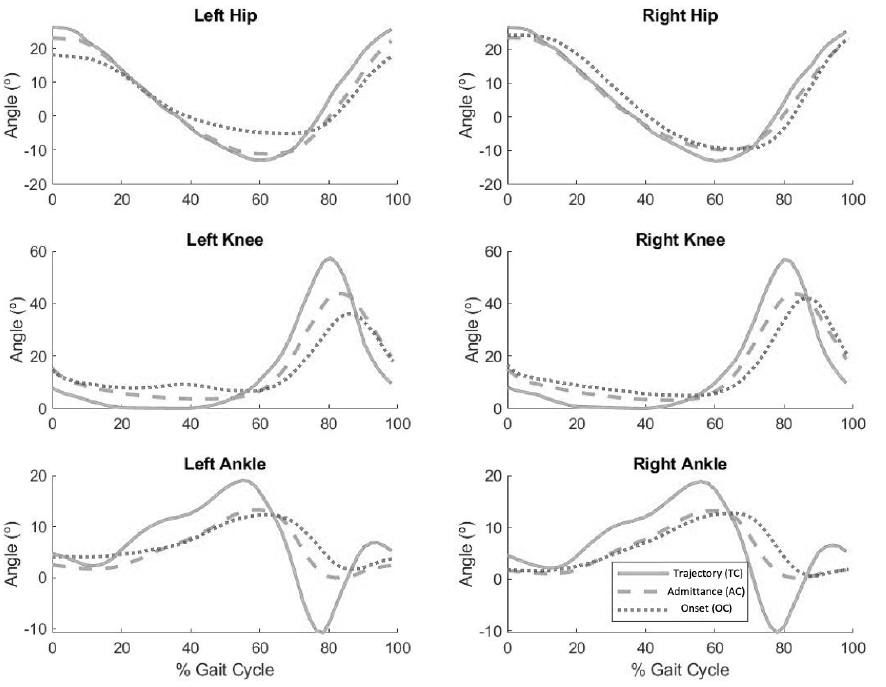
Figure 7. Average ankle, knee and hip joint angles when walking with TC (continuous), AC (dashed) and OC (dotted) controllers. Table 1. (Max) and (Min) angle and (ROM), of ankle, knee and hip joints for each tested controller. Positive values indicate knee flexion, hip flexion and ankle dorsiflexion. 1 statistical difference between TC and AC controllers; 2 statistical difference between TC and OC controllers; 3 statistical difference between AC and OC